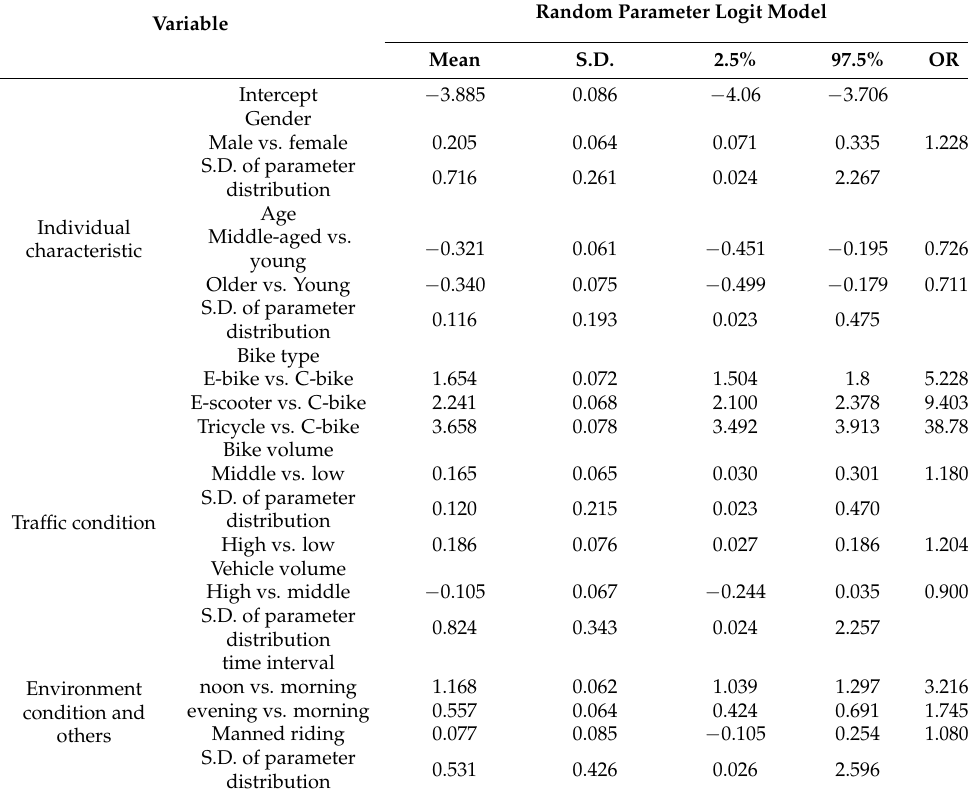
Table 8. Estimation from the Bayesian random parameters logit model at pedestrian–bicycle shared